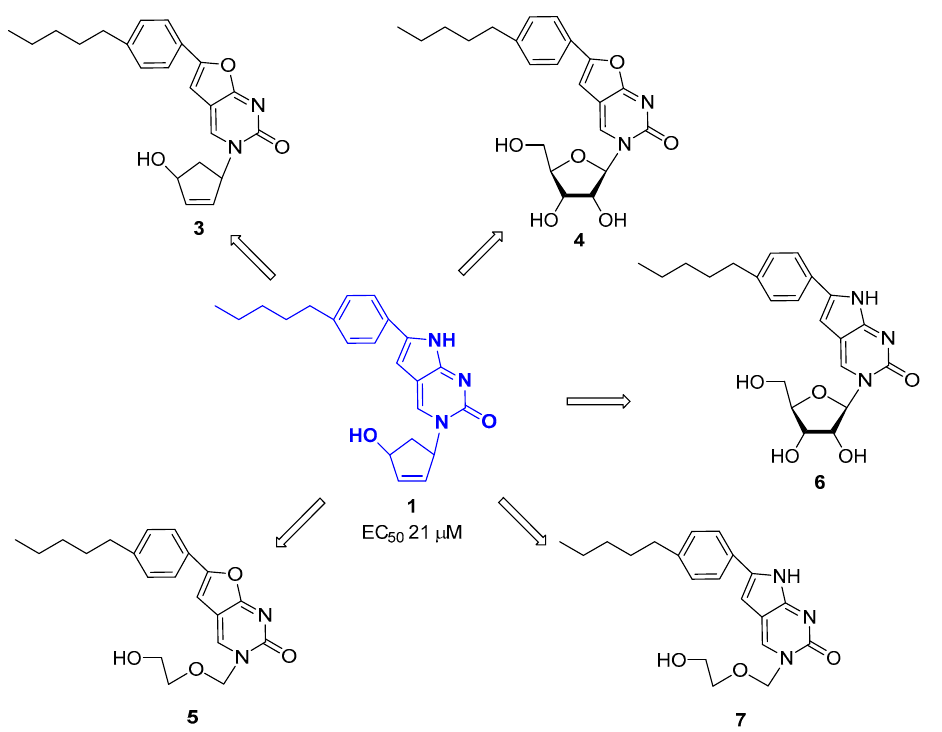
Figure 1. Directions of 1-(4’-hydroxy-2’-cyclopenten-1-yl)-6-(4-pentylphenyl)-3H-pyrrolo [2,3-d]- pyrimidine-2-one (compound 1 ) modification.